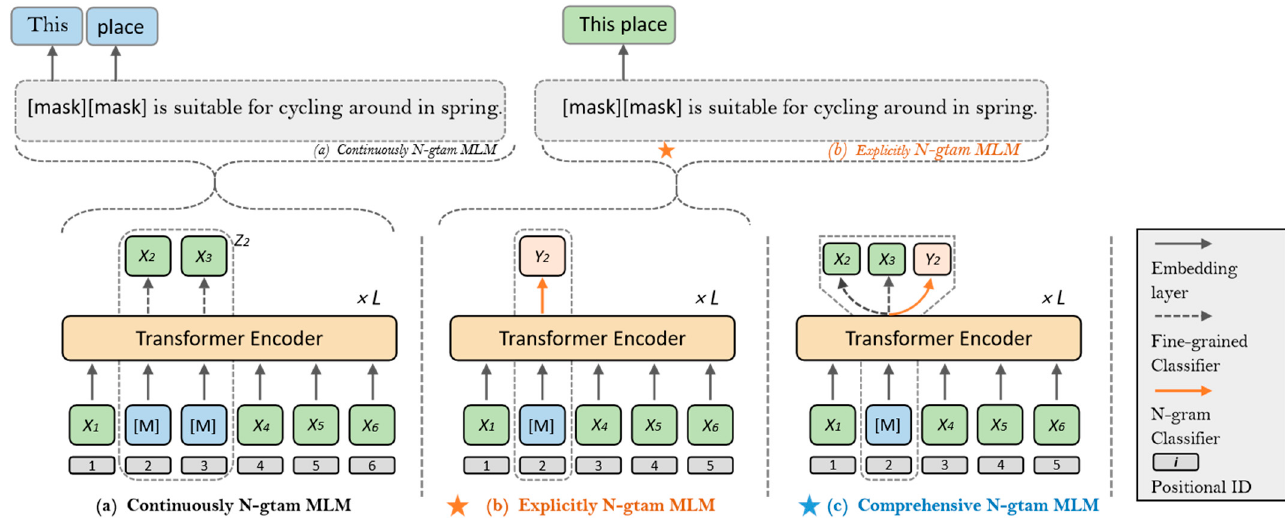
Figure 3. Comparison of ERNIE-Gram and ERNIE mask mechanisms.